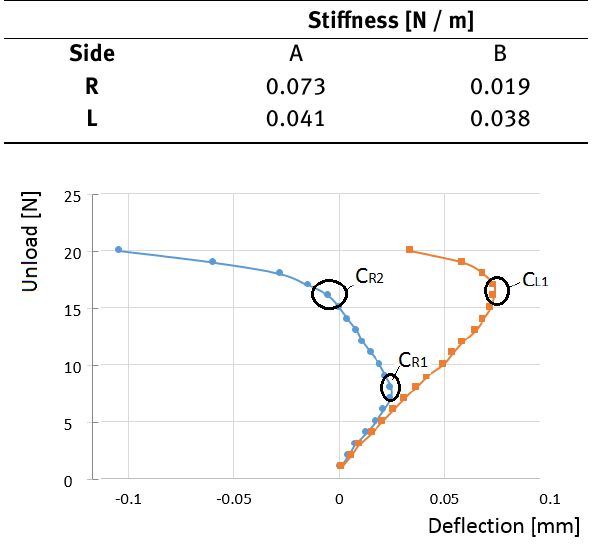
Figure 5: Residual deflection disruption after unloading. Source: Own